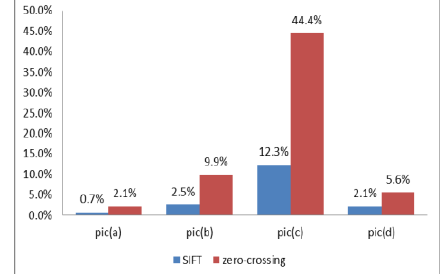
Figure 3(b) feature recurrence rate of SIFT algorithm and zero- crossing algorithm. Blue bar for SIFT algorithm and red bar for zero-crossing algorithm. The x-axis showed different group of test images and the y-axis stands for the feature recurrence